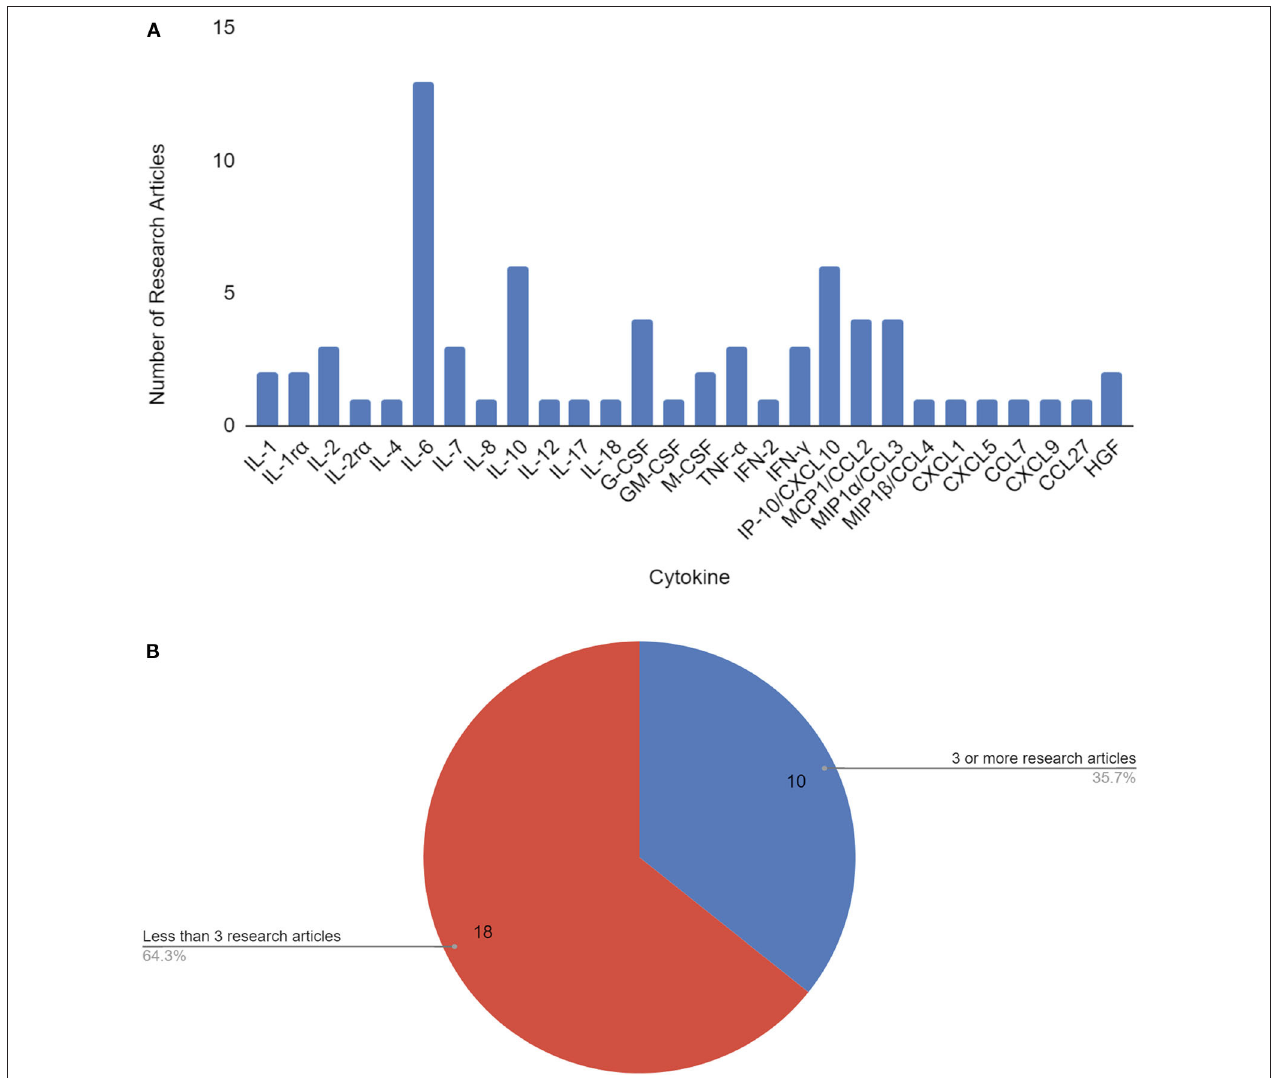
FIGURE 1 | Cytokines by number of research articles identifying the cytokine to be associated with COVID-19 disease severity and/or cytokine storm (A) . Cytokines used in further analysis (10) were associated with 3 or more papers that cited them as correlated with COVID-19 disease severity and/or cytokine storm (B)